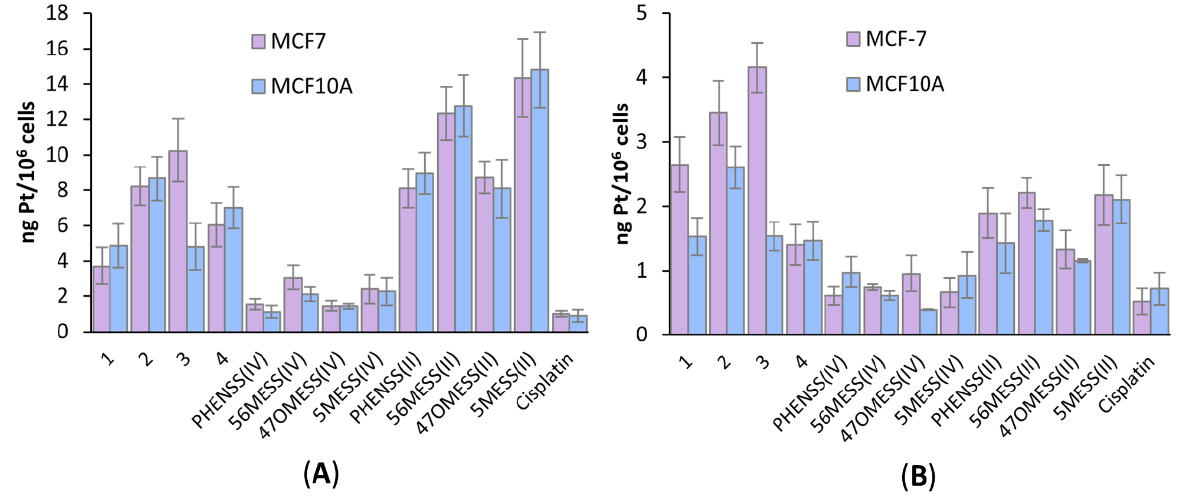
Figure 11. Cellular accumulation levels of 1 – 4 , their platinum(II) and platinum(IV) precursors and cisplatin against MCF-7 (breast cancer) and MCF10A (healthy breast) cells that were treated for 4 h, at 1.0 µM ( A ) and 0.1 µM ( B ) concentrations. Values are reported in ng/10 6 cells and are reported with standard error of the mean; produced from three independent experiments.